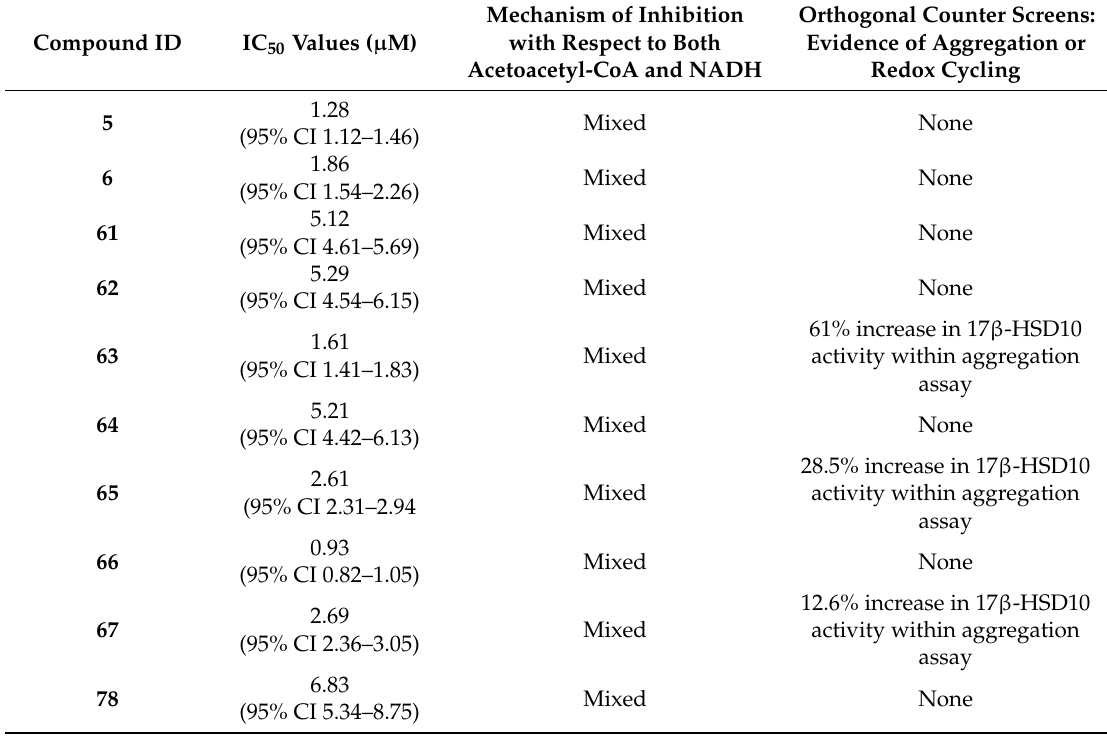
Table 5. Biophysical characterisation of compound of interest.